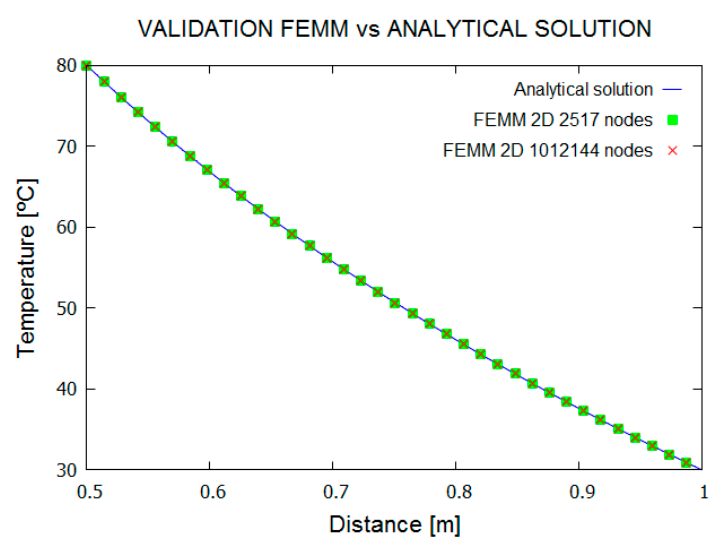
Figure 4. Validation of FEMM vs. analytical solution.